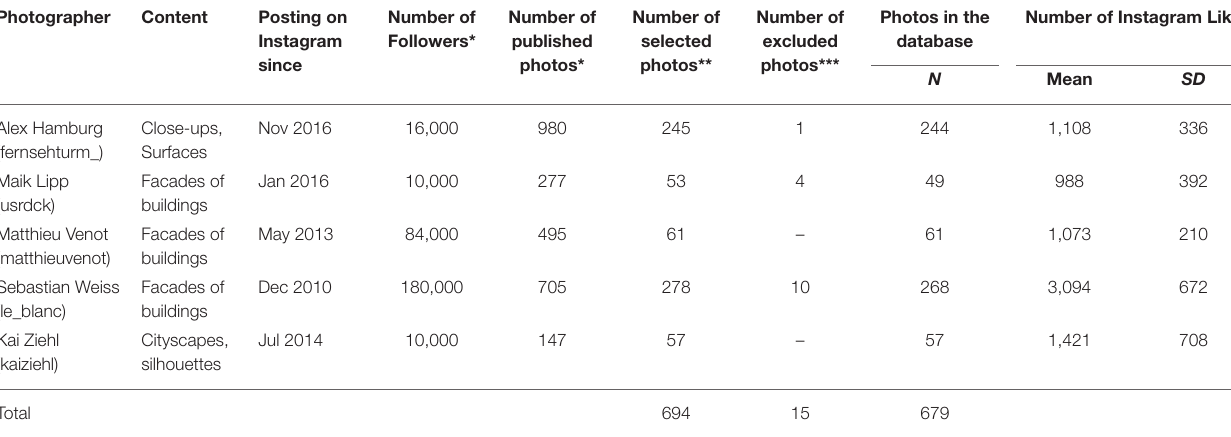
TABLE 1 | This table describes the characteristics of the selected photographers (Instagram names in parentheses). Photographer